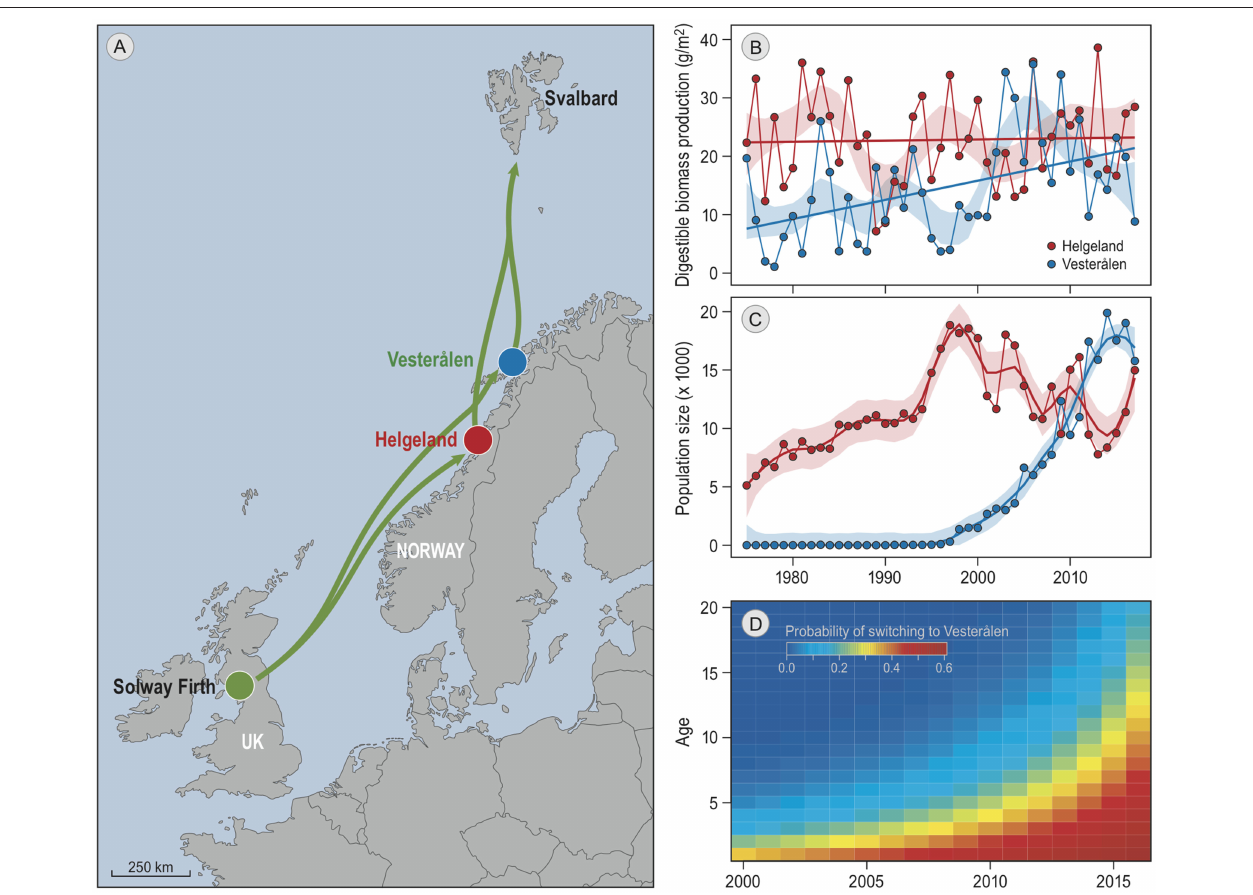
FIGURE 1 | Barnacle goose spring-staging sites. All panels are reproduced from Tombre et al. (2019). (A) is a map of the migratory route (green arrows), and the two staging sites in red and blue. The geese winter at the Solway Firth, and breed on Svalbard. (B) shows the annual estimated staging site quality at both staging sites, estimated as the sum of the daily digestible biomass growth of grass leaves during the staging period. The lines are linear regressions and the shaded areas delineate the 95% confidence interval of local regressions. Panel (C) shows the number of spring staging geese at the two sites as found by the same study. Lines are the trends estimated by local regression, the colored areas depict confidence intervals. (D) shows the probability of geese of particular ages (y-axis) in each year (x-axis) to switch from staging in Helgeland to staging in Vesterålen in the subsequent year, as obtained from resightings of individually marked